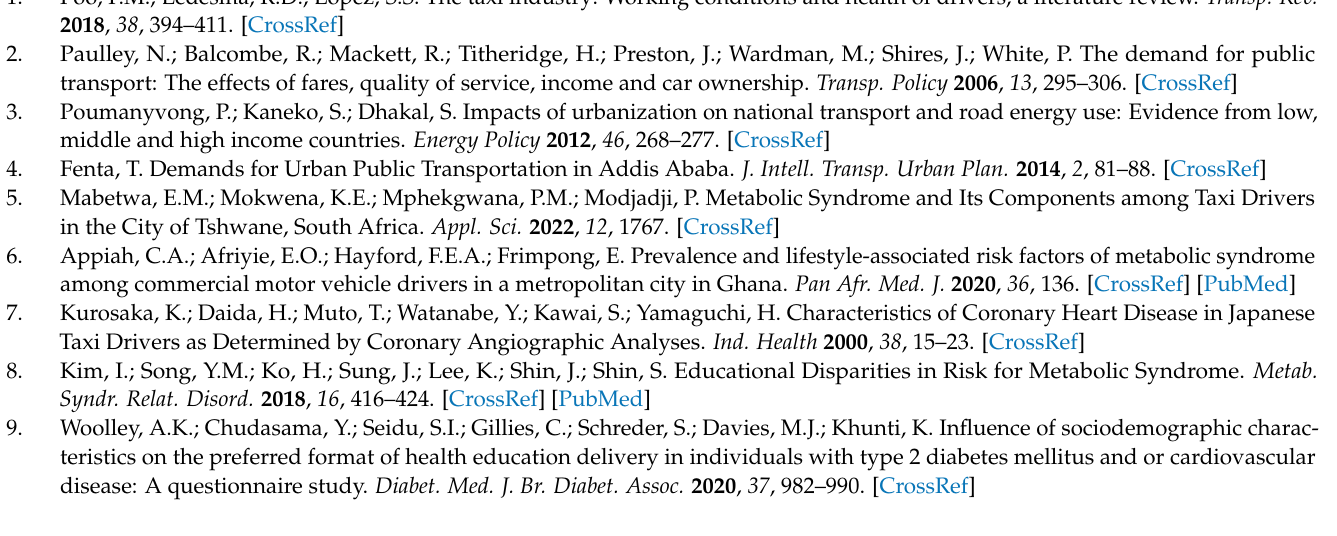
groups. Table S2: Characteristics of commercial taxi drivers by study area. Table S3: Prevalence of PBDs according to study